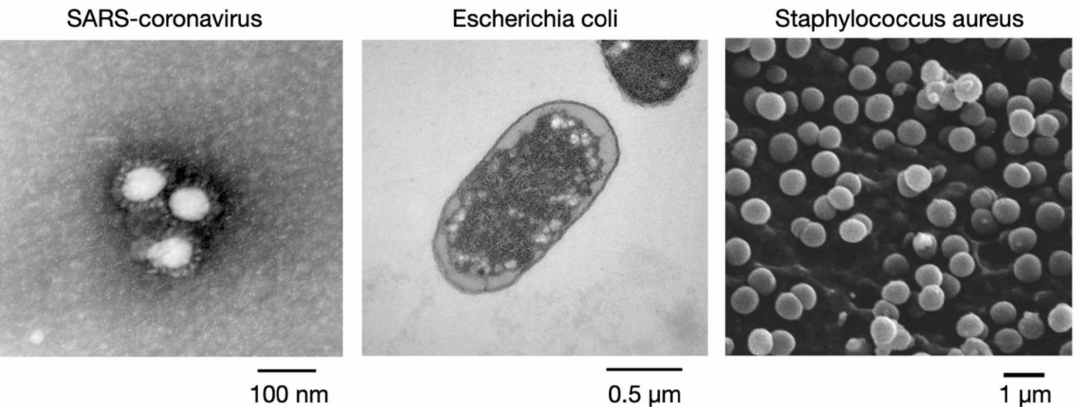
Figure 2. Schematic of the tested virus and bacteria (Source: EM Atlas of Clinical Microbes, Taiwan Centers for Disease